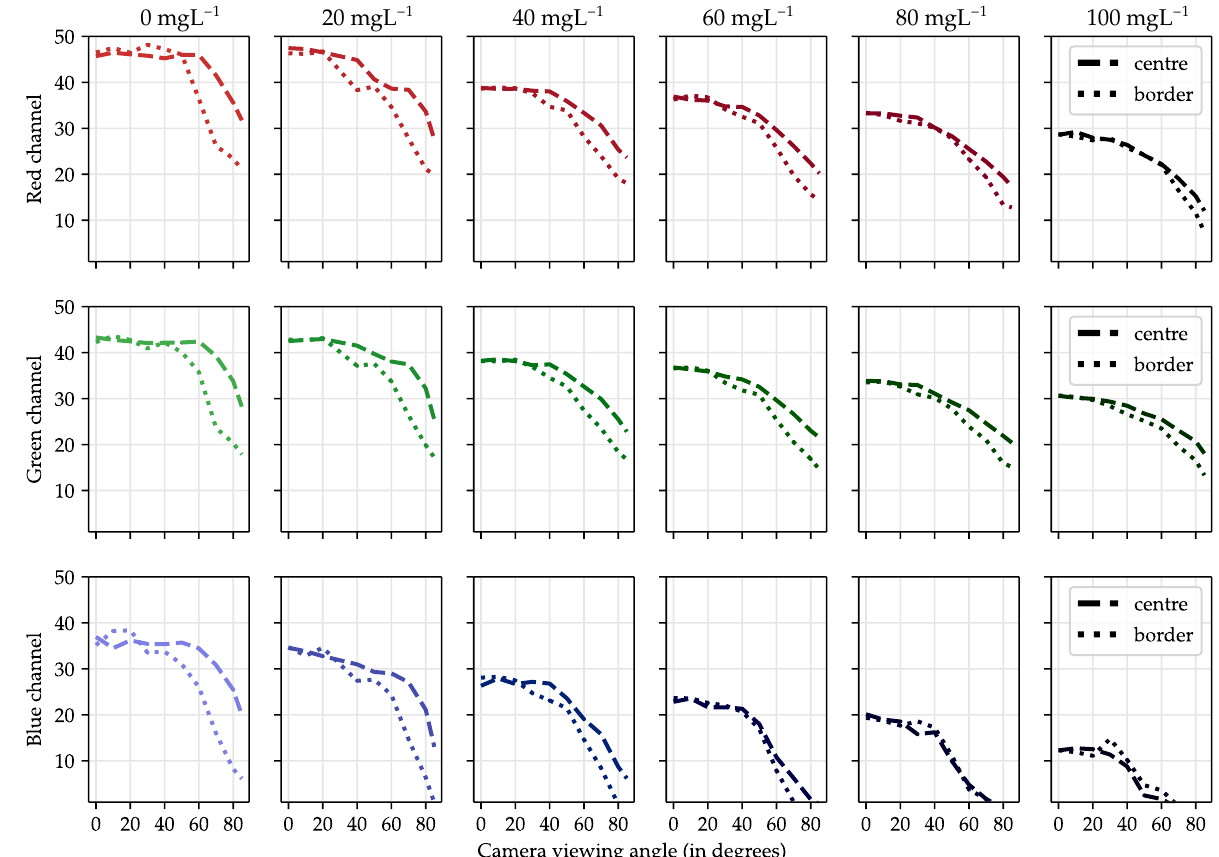
Figure 10. Red, green and blue SNR for small areas located at the centre and the border of the